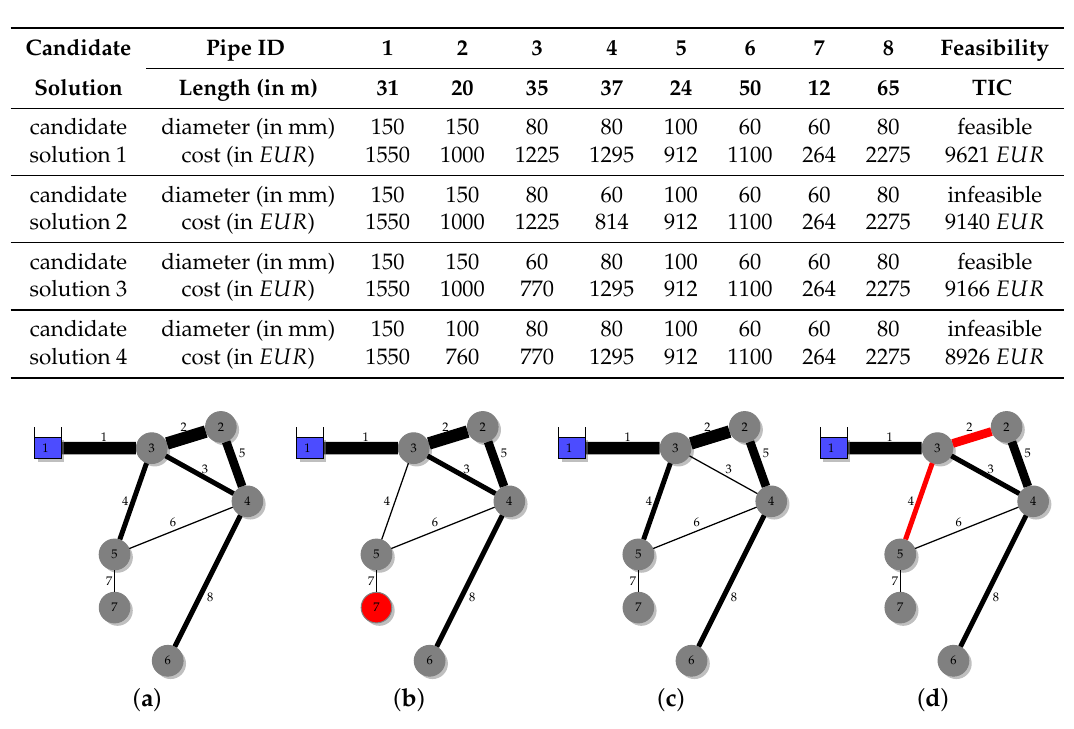
Table 1. Different solutions or network designs in vector representation.